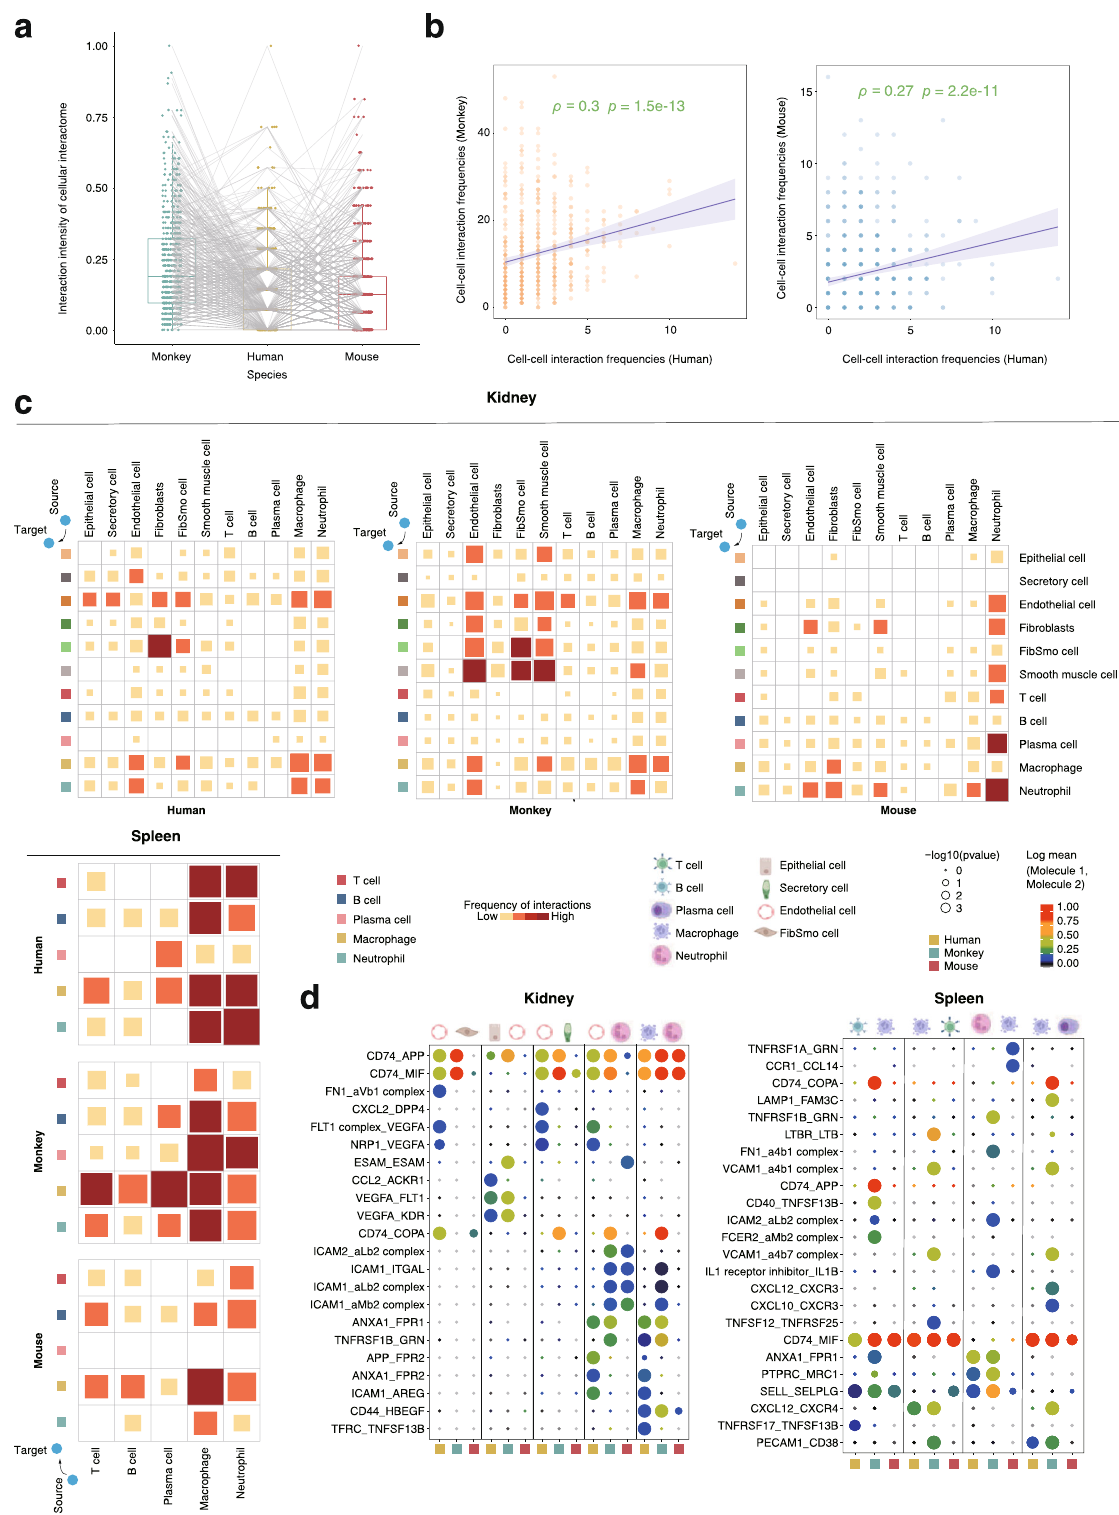
Fig. 10 Conserved and divergent cell – cell interactions in human, mouse and cynomolgus monkey. a Box plot indicating the relative frequency of cell – cell interactions among human, monkey and mouse. Each point denotes a speci fi c intercellular interaction in a speci fi c organ. The number of signi fi cant cell – cell interactions are scaled to a range from 0 and 1 for inter-species comparison. b Scatter plots show the Spearman ’ s rank correlation of cell – cell interaction frequencies between human and monkey (left) or between human and mouse (right). P -values are provided (two-sided Spearman ’ s correlation test). The fi tted line and standard errors with 95% con fi dence intervals are shown. c The heatmaps showing the strength of interactions among the common major cell types in kidney and spleen in the three species. The size and color of the blocks are proportional to the frequency of interactions. P -values were calculated by CellPhoneDB without multiple comparisons. d Dot plot of interactions between major cell subtypes in kidneys and spleens of different species. Each row represents a ligand-receptor pair, and each column de fi nes a cell – cell interaction pair in a